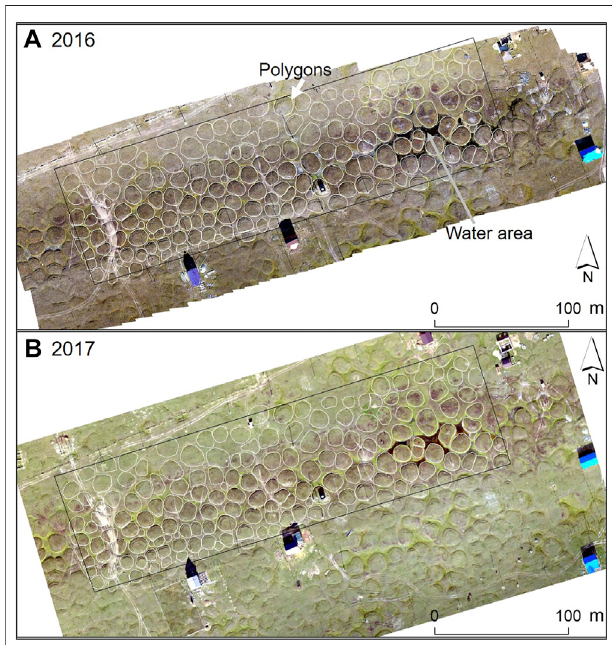
FIGURE 4 | Orthorecti fi ed images taken by UAS at the disused air fi eld site (T4 in Figure 2B ) for (A) 2016 and (B) 2017. White lines in both photos denote the boundary of polygons.